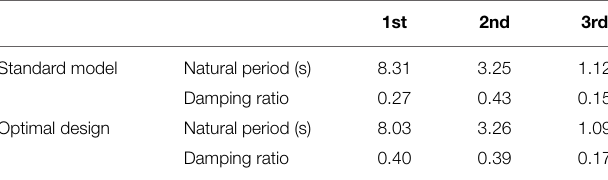
TABLE2 | Responsecharacteristics of various models under representative two-type ground motions .